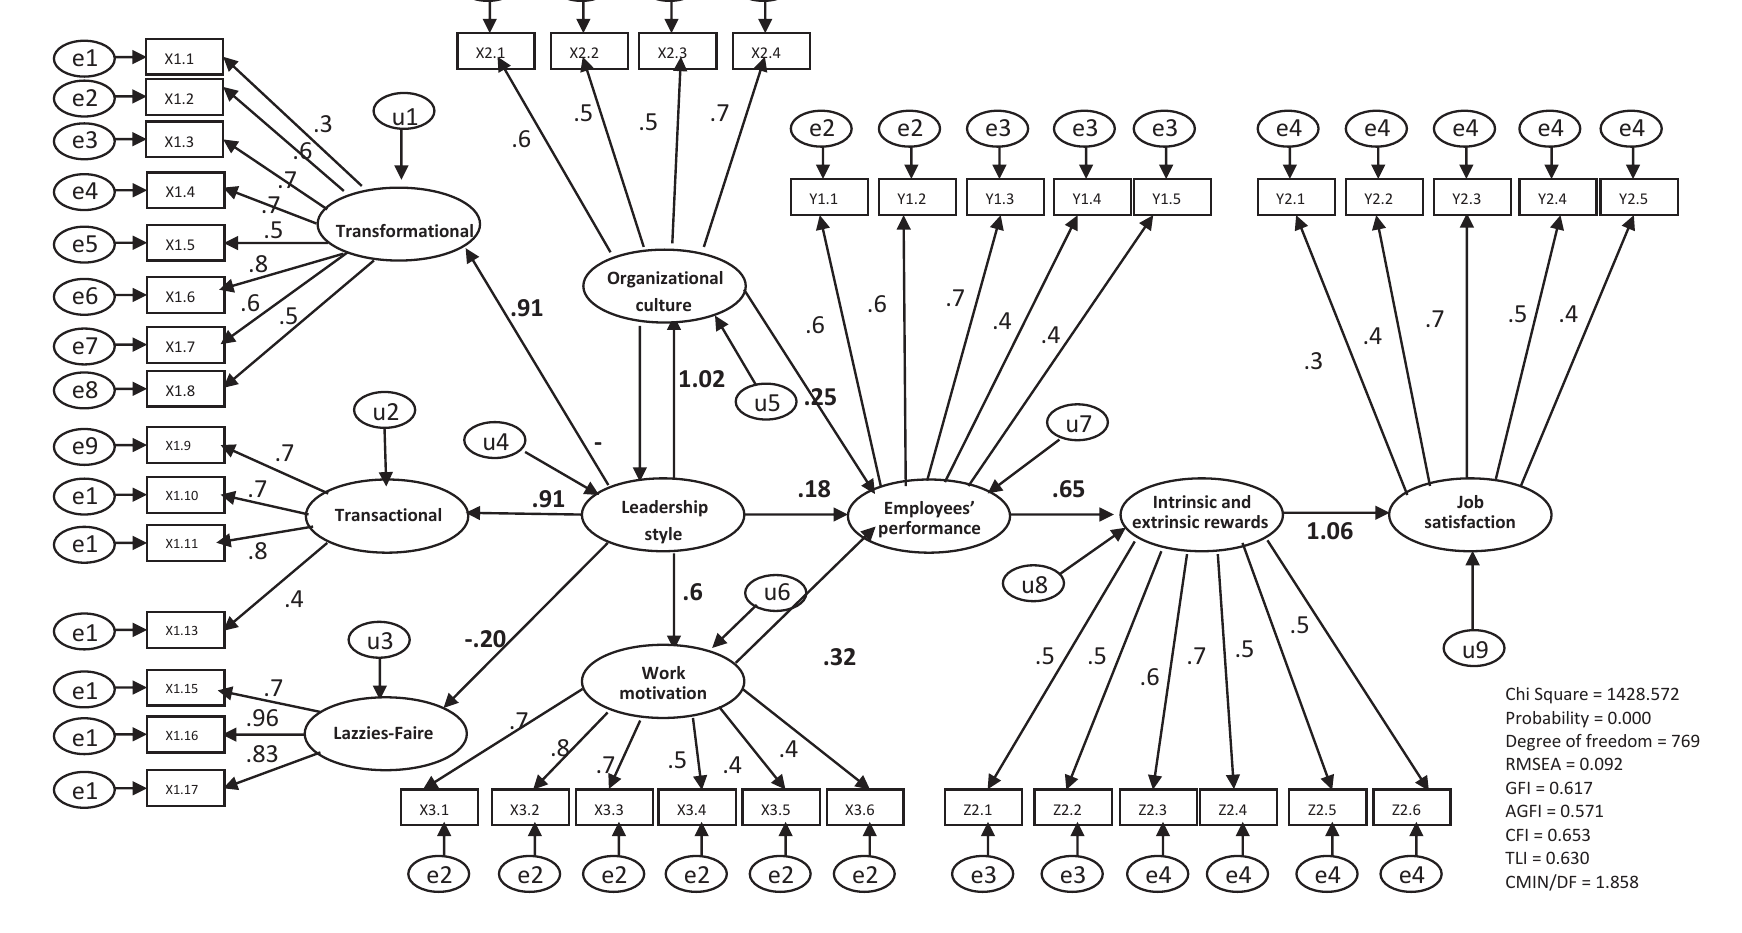
Figure 3. The results of early test of the relation between variables and female middle